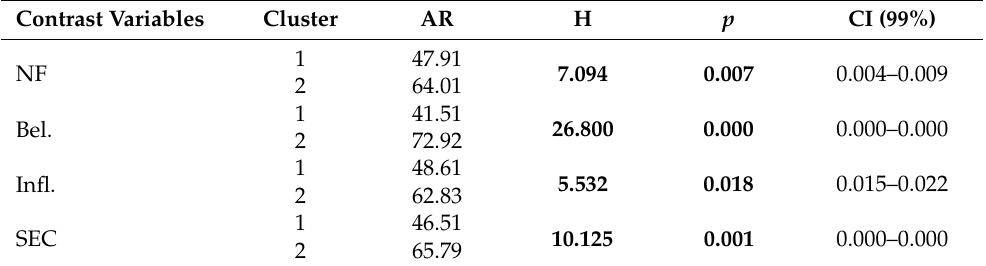
Table 3. Non-parametric tests for assessing the role equivalence